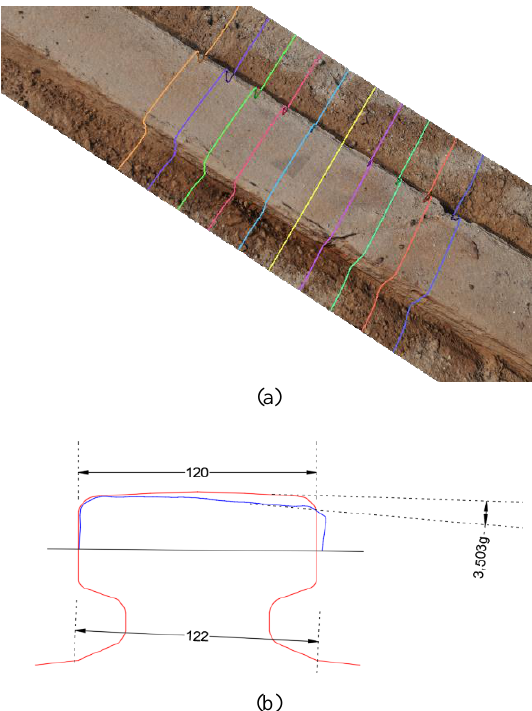
Figure 16. Profile of the structure. a) indications of the sections; b) comparison between designed profile (red colour) and real model (colour blue)